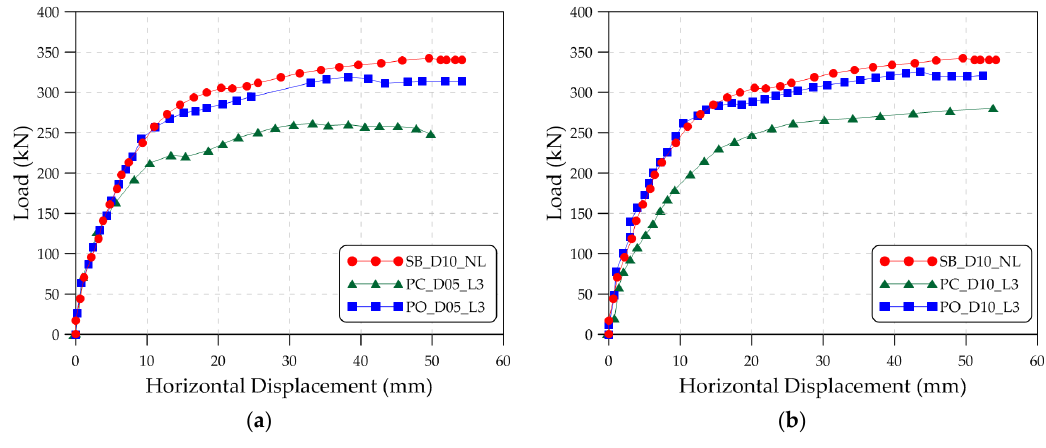
Figure 9. Effect of steel pile cap strengthening methods. ( a ) D05_L3 specimens. ( b ) D10_L3 specimens. Table 4. Effect of steel pile cap strengthening methods for D05_L3 specimens.